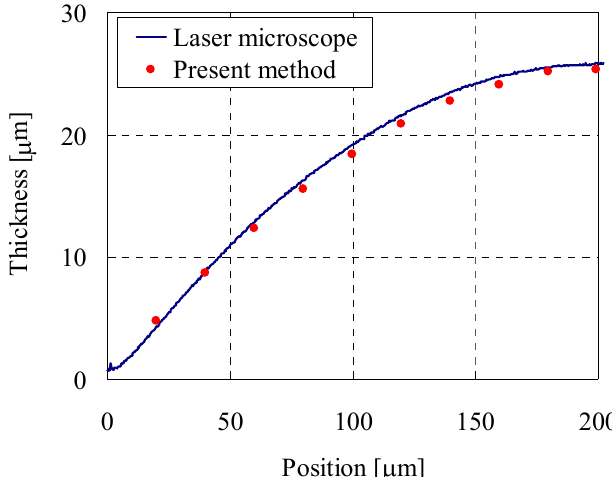
Fig. 8 Accuracy validation of micro droplet compared with laser con-focal